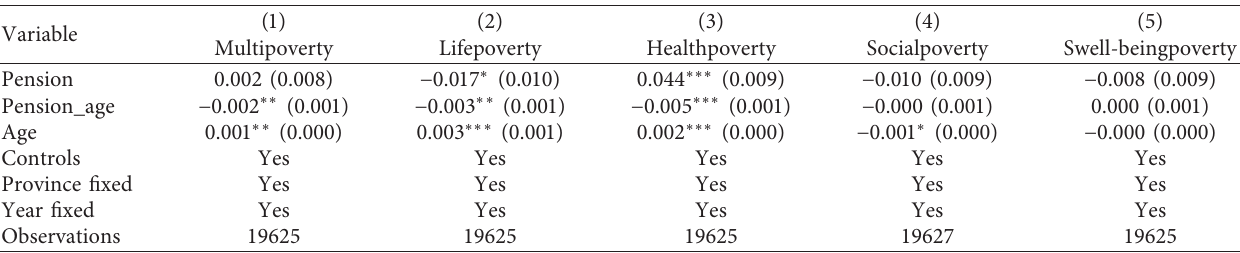
Table 7: Poverty-reduction effect of insured-subsamples’ receiving the NRPS income—adding an age interaction term.